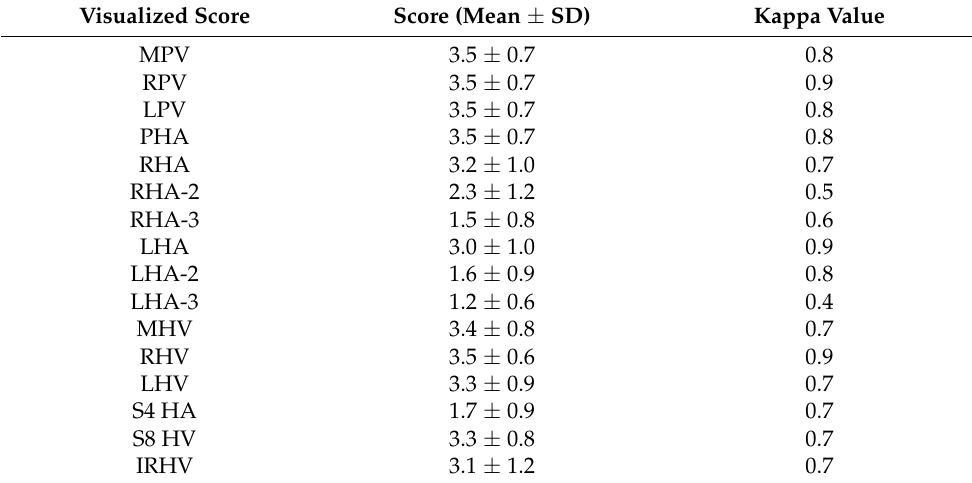
Table 1. Mean image quality scores and interobserver